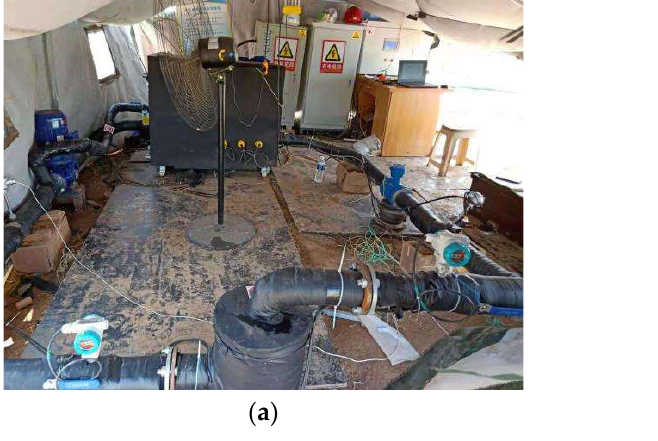
Figure 12. Test site. ( a ) A view of the entire test bench. ( b ) Sketch map of a double-pipe heat exchanger.